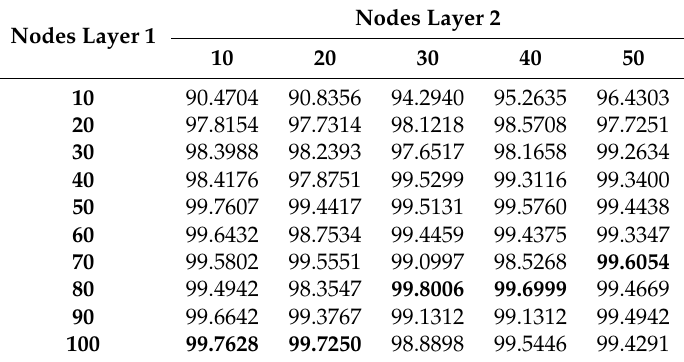
Table 1. Accuracy results (%) depending on the number of nodes in hidden layers.